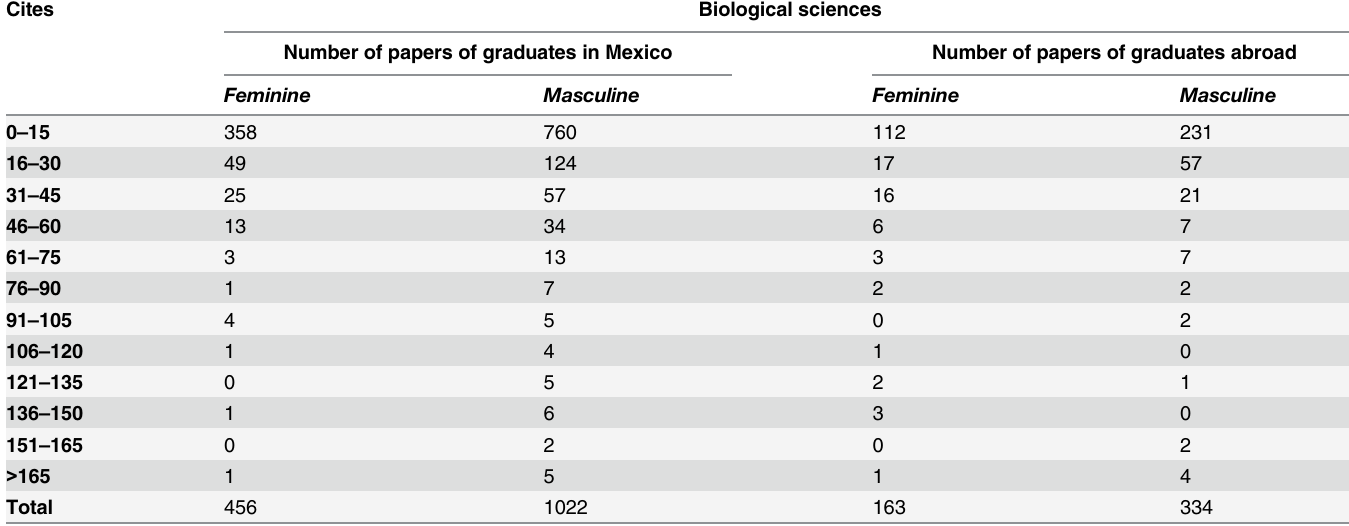
Table 9. Cites vs. number of papers published by the Mexican diaspora in biological sciences by gender and country of PhD.